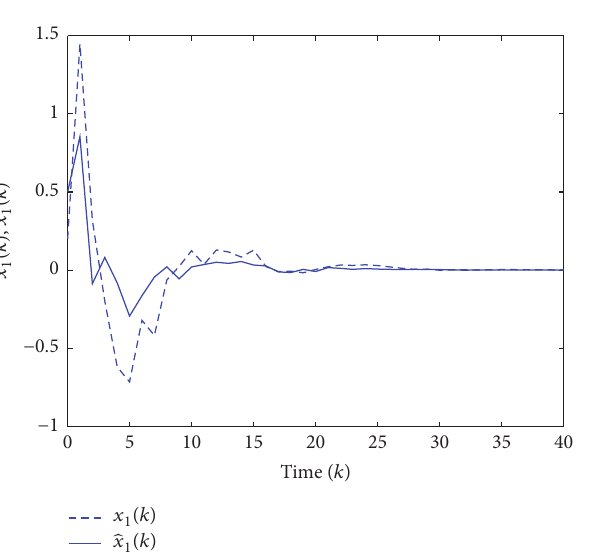
Figure 5: Estimation error ̃𝑧(𝑘)